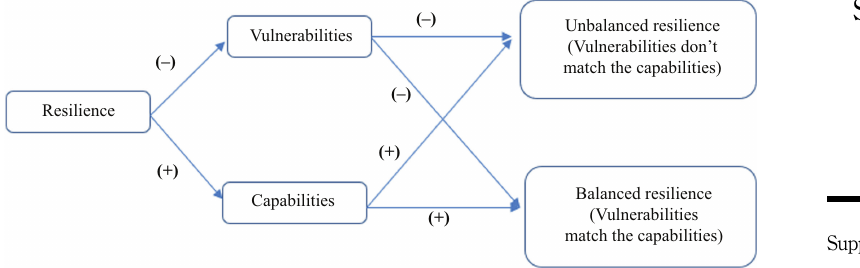
Figure 1. Supply chain resilience